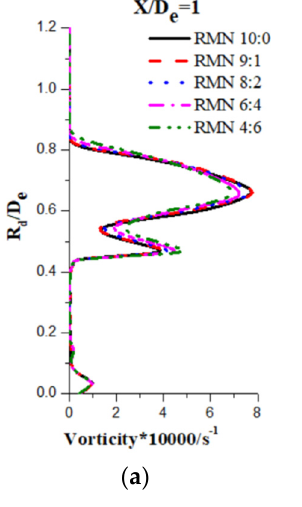
Figure 11. Vorticity magnitude radial distributions at various axial locations for three jets: ( a ) methane: nitrogen ratio (RMN) = 10:0, ( b ) RMN = 8:2, and ( c ) RMN = 4:6.